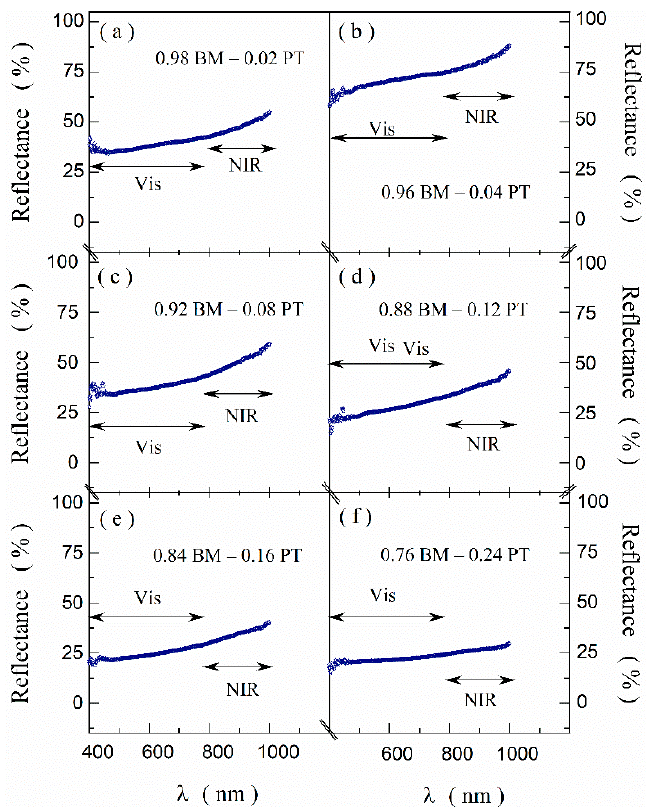
Figure 10. Reflectance, R , vs. wavelengths, λ , dependence measured for (1 − x ) BM– x PT ceramics, x = 0.02, 0.04, 0.08, 0.12, 0.16, 0.24, ( a – f ), respectively.